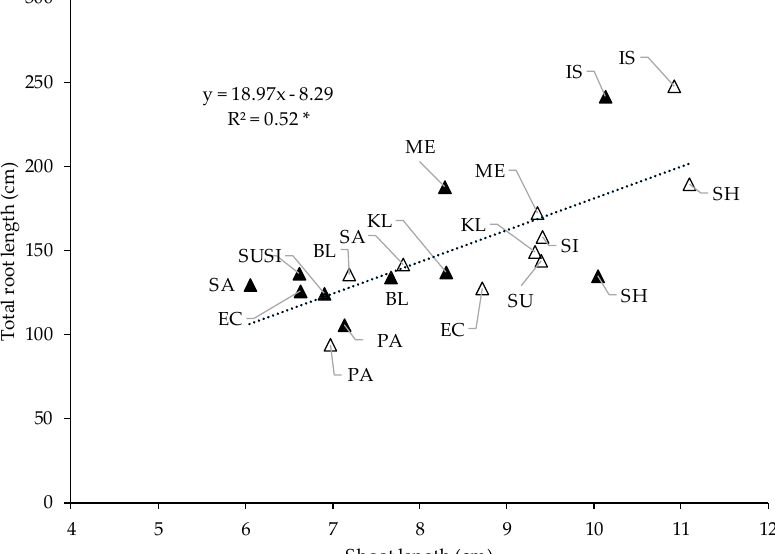
Figure 3. Total root length (cm) as a function of the shoot length (cm) for 10 soybean cultivars at 10 days after sowing. Linear regression was carried out for the two soil moisture status. “*” indicates that regression is significant at p < 0.05 according to the table proposed by [46]. ( ▲ ) and ( ∆ ) for well-watered and water-stressed conditions, which correspond to a volumetric soil water content (mean% ± standard error: 25 ± 1.44 and 14 ± 1.13, respectively). Cvs. Blancas (BL), Ecudor (EC), ES Mentor (ME), ES Pallador (PA), Isidor (IS), Klaxon (KL), RGT Shouna (SH), Santana (SA), Sigalia (SI) and Sultana (SU).